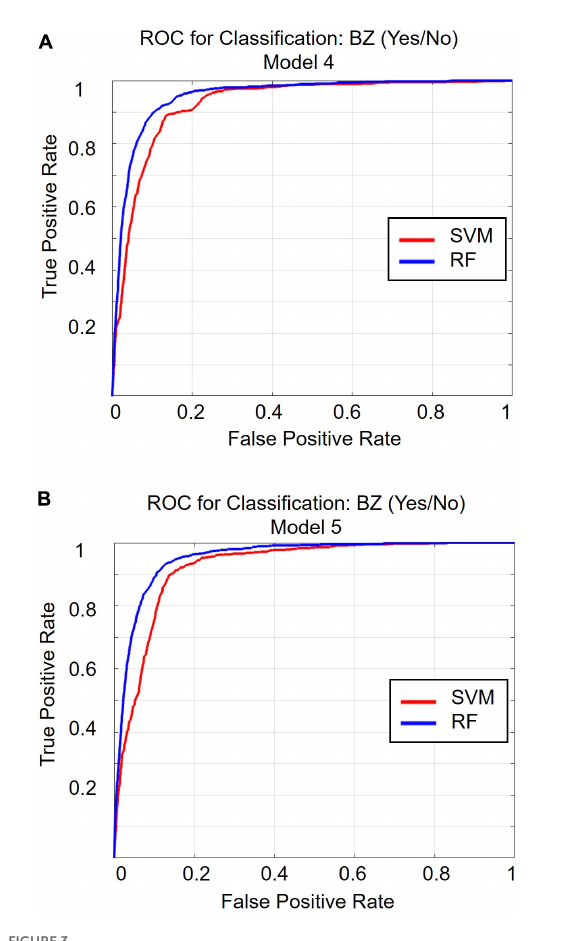
FIGURE3 Receiver operating characteristic curve for classification Model 4 (A) and for classification Model 5 (B) . ROC, receiver operating characteristic curve; BZ, benzodiazepine; SVM, support vector machine; RF, random